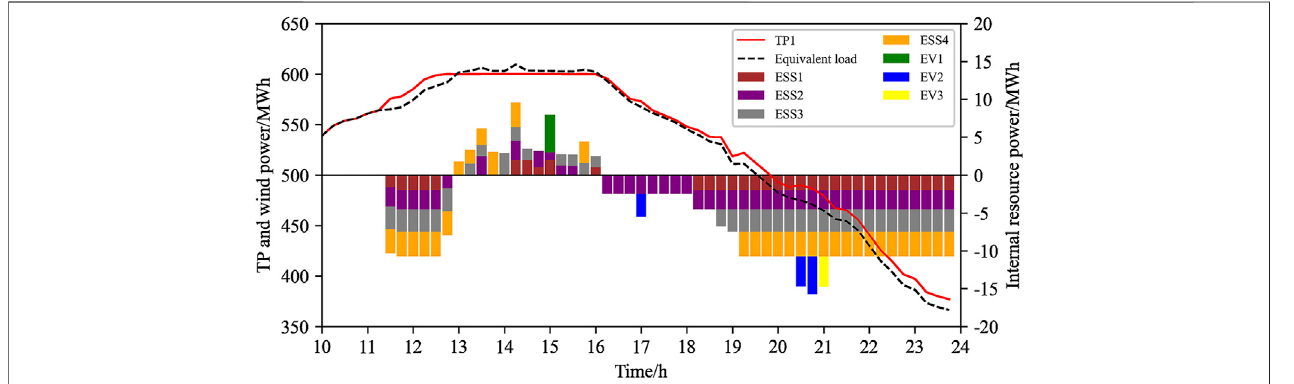
FIGURE 6 | Day-ahead planned output power curve of adjustable resources.